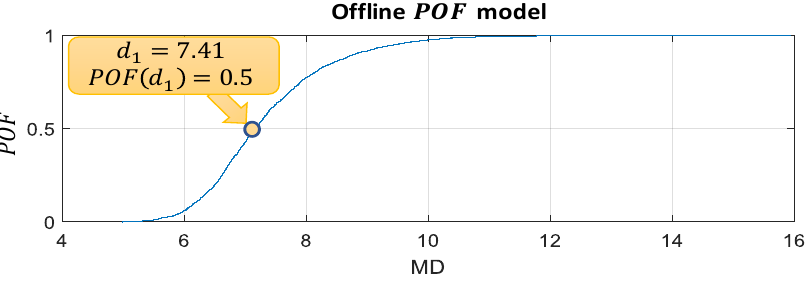
Figure 7. Offline POF model for case Figure 7. Offline 𝑃𝑂𝐹 model for case 1.